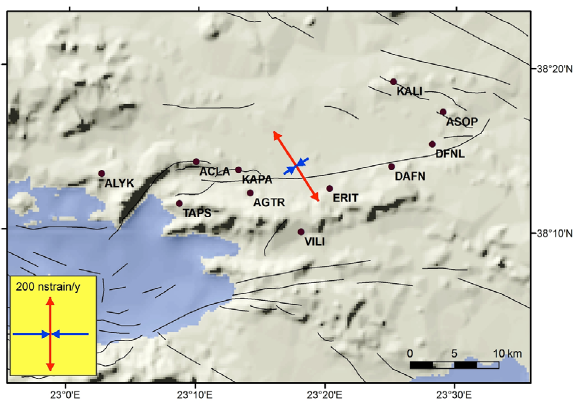
Figure 7. Strain rate field inferred from GPS velocities of the whole Kaparelli–Asopos region. Black solid circles indicate station loca- tions. Red arrows indicate extension, blue arrows compression. 1 ns/yr corresponds to an annual motion of 1 mm over a distance of 1000 km. Grey lines are active faults [Ganas et al.